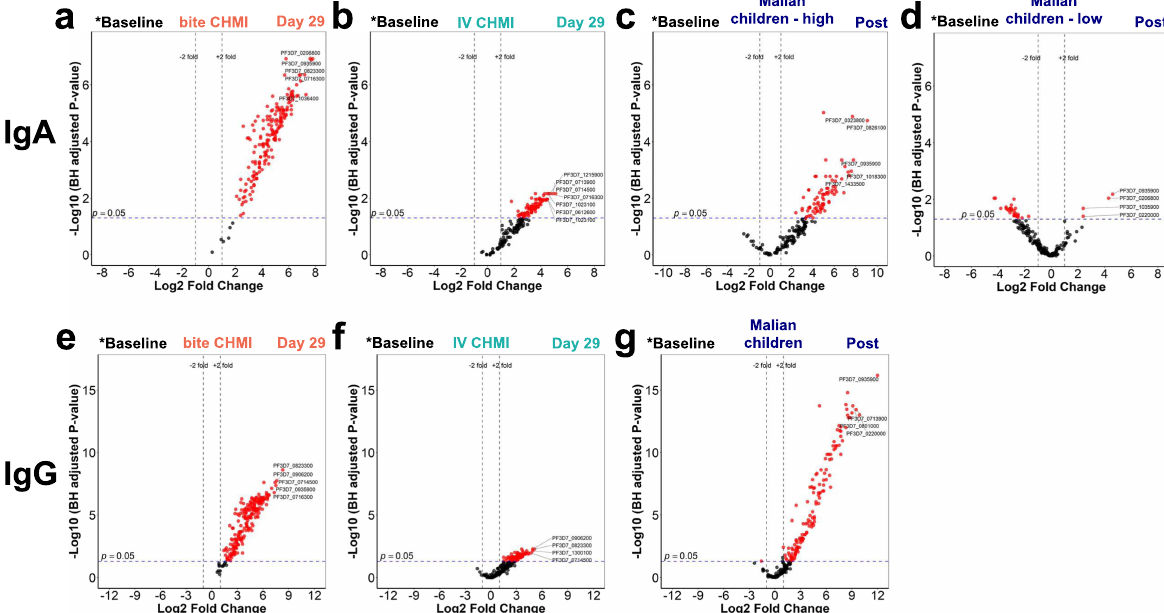
Fig. 3 Changes in IgA and IgG antibody responses to P. falciparum proteins in three clinical studies. Volcano plot of IgA ( a – d ) and IgG ( e – g ) comparing baseline (CHMI timepoint day 1) signal intensities to the study-speci fi c post-infection timepoint day 29 for bite CHMI ( n = 32) ( a , e ), IV CHMI ( n = 22) ( b , f ) and post-infection for Malian children ( n = 47) ( c , d , g ), with the Malian children grouped by high vs. low correlation with the CHMI adults (as illustrated in Fig. 2). Antigens are colored red if they pass the thresholds for false discovery rate (FDR) and Log Fold change; the top antigens by p value and fold change are labeled. Antigens above the blue dashed line have Wilcoxon rank sum p < 0.05 after correction using the Benjamini Hochberg procedure. Analysis was done on 193 antigens for IgA and 228 antigens for